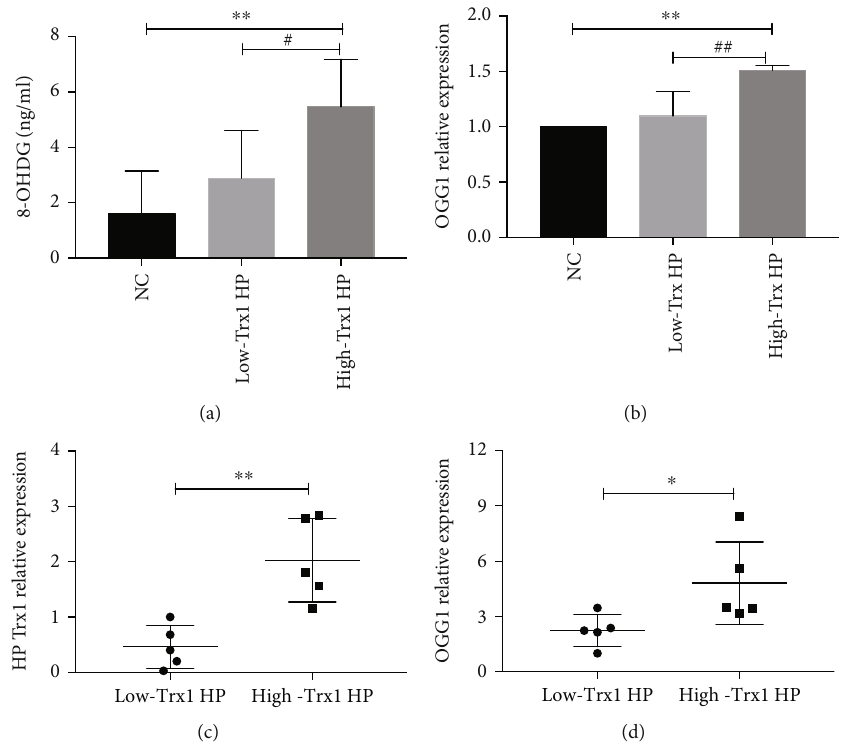
Figure 5: The high-Trx1 HP can cause much more serious DNA damage. (a) The 8-OHDG expression of GES-1 cell during low-Trx1 HP and high-Trx1 HP infection was analyzed by ELISA. (B) The OGG1 expression of GES-1 cell during low-Trx1 HP and high-Trx1 HP infection was analyzed by real-time PCR. (c, d) The expression of HPTrx1 and OGG1 in HP positive gastric mucosa ( n = 10 ) was analyzed by real-time PCR. Note: NC means uninfected control group, low-Trx1 HP means HP with lowTrx1 expression, and high-Trx1 HP means HP with high Trx1expression, ∗ P < 0 : 05 , ∗∗ P < 0 : 01 , ## P < 0 : 01 , and ### P < 0 : 001 .